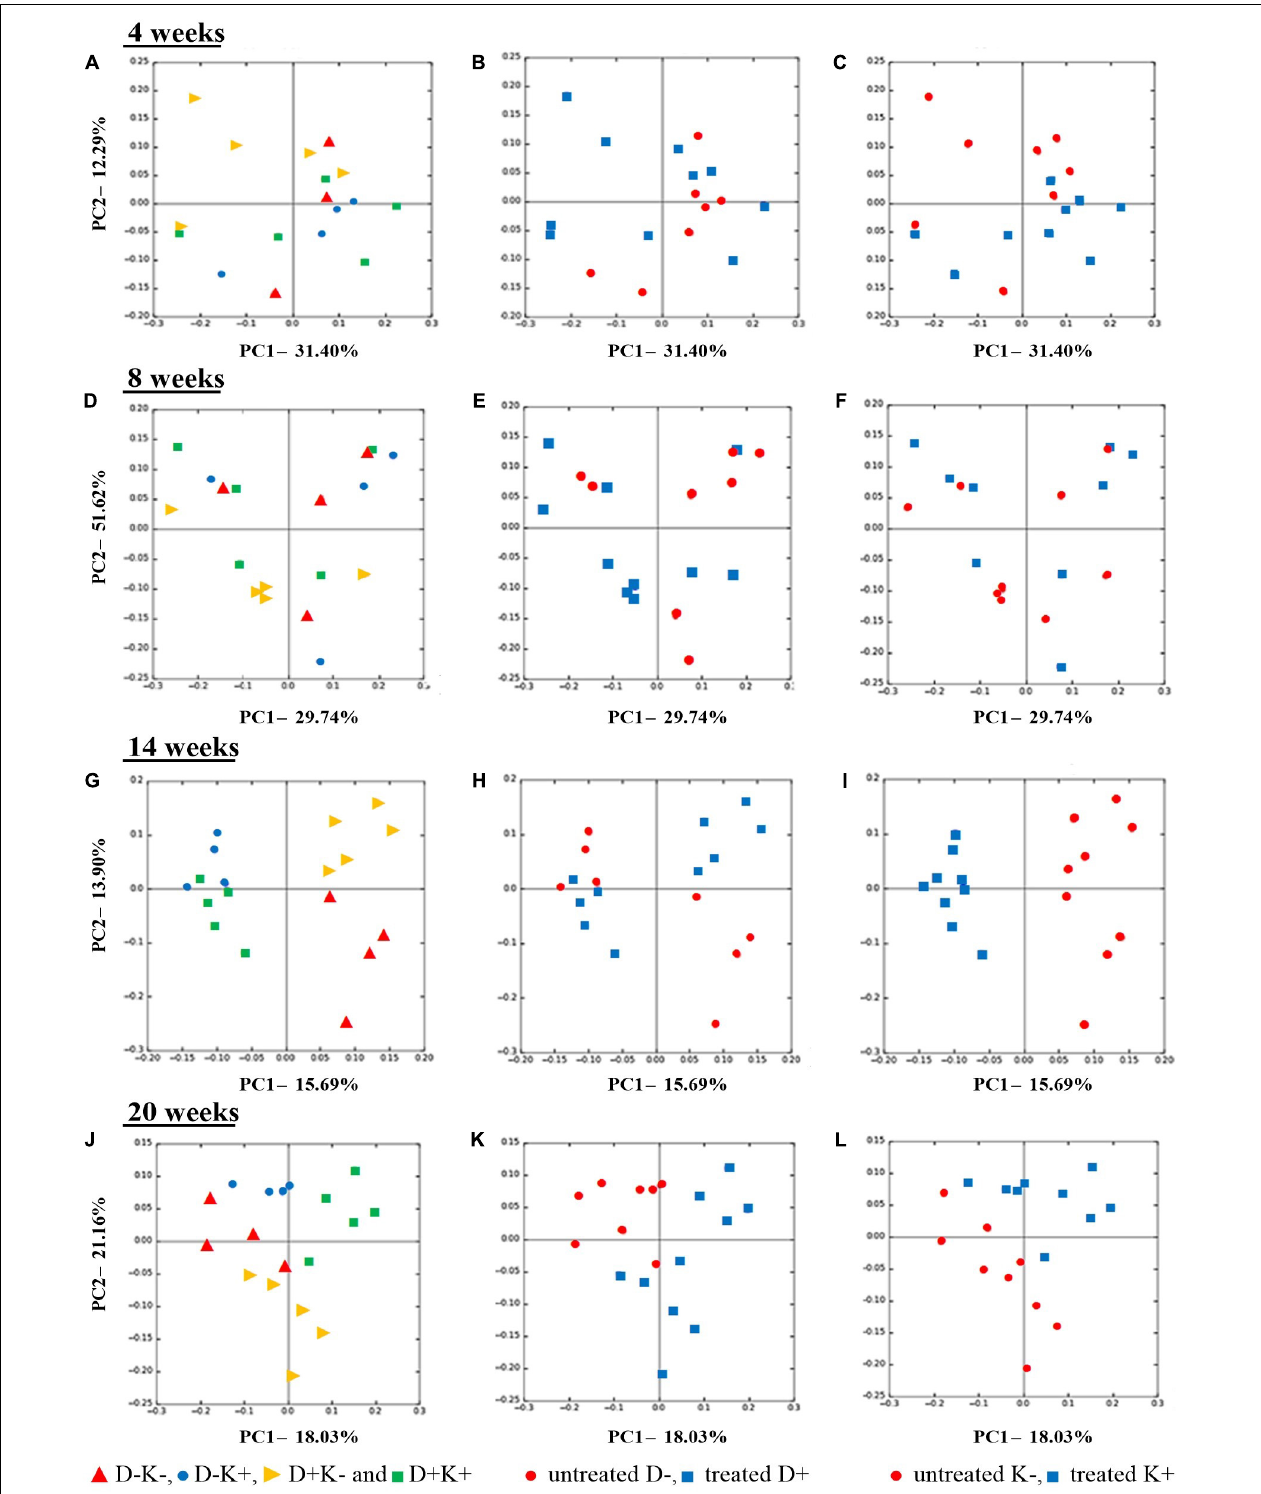
FIGURE 3 | Principal coordinate analysis (PCoA), based on Bray-Curtis dissimilarity indices at OTU level, of the rumen bacterial community structure of goat kids pre weaning (4 weeks), at weaning (8 weeks) and post weaning (14 and 20 weeks). Kids were treated prenatally through supplementation of L. leucocephala forage meal in their mothers’ diet during the last 7 weeks of pregnancy (D + ), postnatally until weaning with yeast (K + ), or not (D − and K − ). Left Figures (A,D,G,J) present all four treatments separately while middle (B,E,H,K) and right (C,F,I,L) figures visualize prenatal and postnatal treatments, respectively.